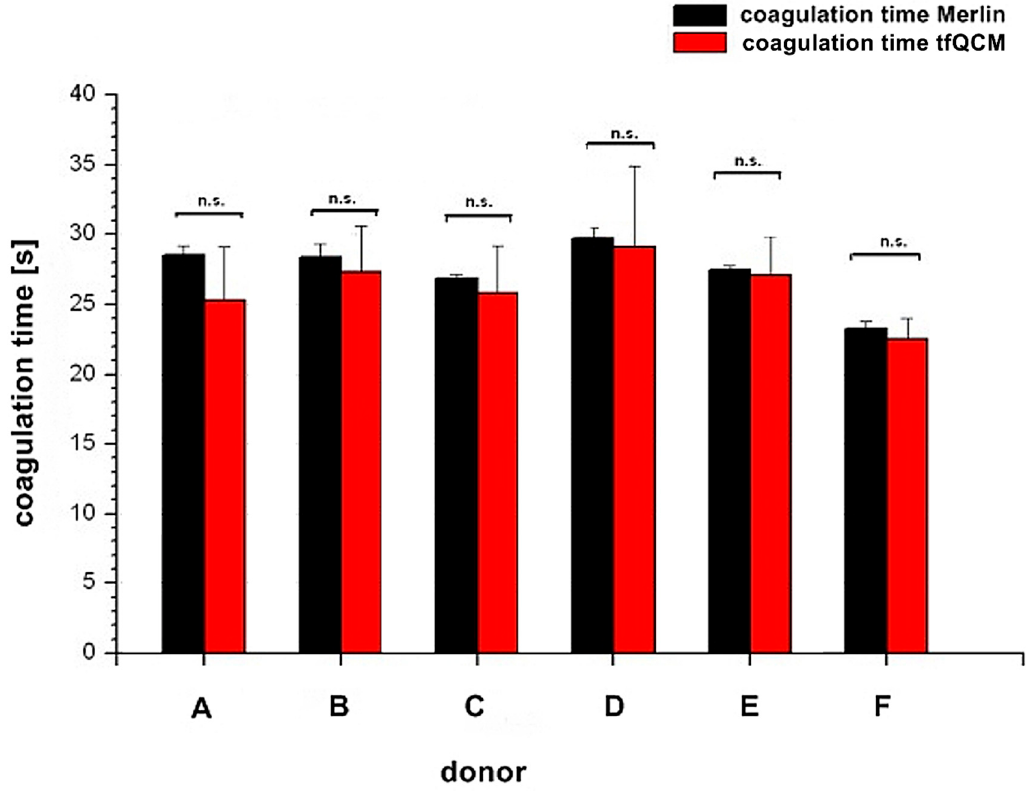
Figure 5. Comparison of coagulation times between Merlin coagulometer (black column) and tfQCM (red column) based on the fibrinogen concentration results in Table 1. The x-axis shows the different donors A–F. The y-axis shows the coagulation time. Results of coagulation time from both parameters are not significant (n.s.) with p ≥ 0.05.